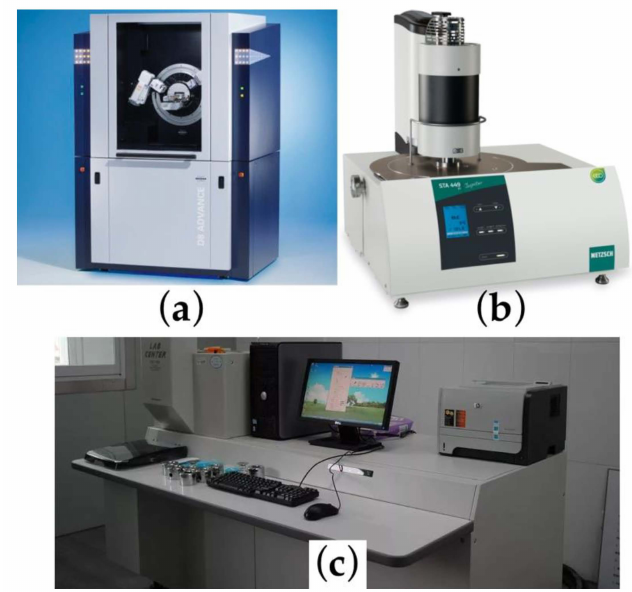
Figure 5. Equipment and research material: ( a )—BRUKER D8 ADVANCE diffractometer; ( b )—STA 449 F1 Jupiter derivative; ( c )—Shimadzu XRF-1800 X-ray fluorescent wave-dispersion